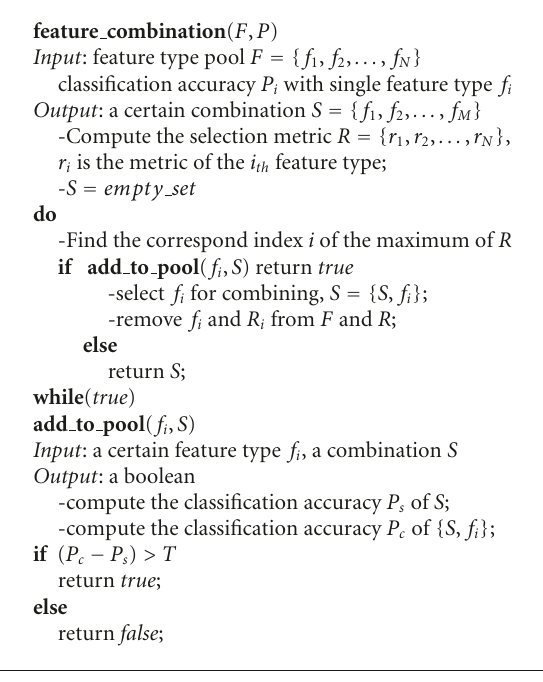
Algorithm 1: The pseudocode of automatic feature